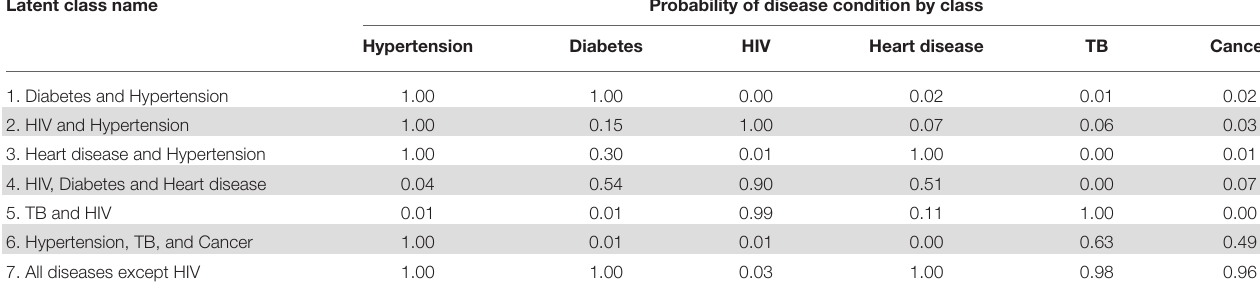
TABLE 5 | Item response probabilities by disease for each latent